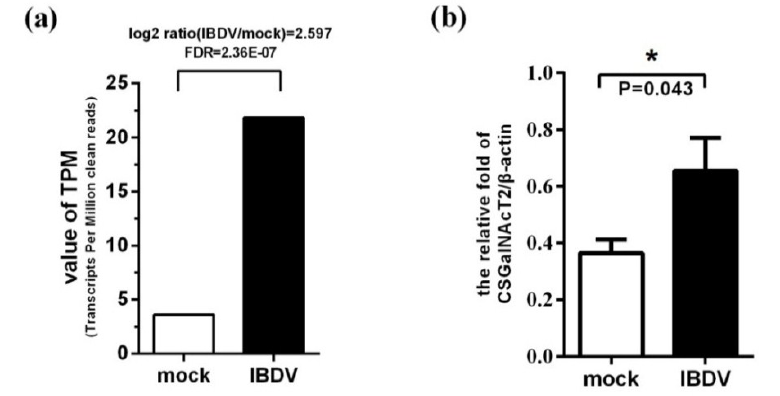
Figure 1. Screening of host cell proteins interacting with VP2 of IBDV by yeast two-hybridization assay. Briefly, the capsid protein VP2 of the IBDV Gt strain was used as the bait in the ProQuest yeast two-hybrid system to screen a cDNA library generated from the chicken bursa of Fabricius cells. The interactions were examined by SD/-Leu/-Trp/-Ura plates and X-gal assay. Ten putative positive colonies were tested for β-galactosidase activity in two additional rounds of selection. The positive (Krev1 and RalGDS-wt) and the negative controls (Krev1 and RalGDS-m2) were performed during each selection round.